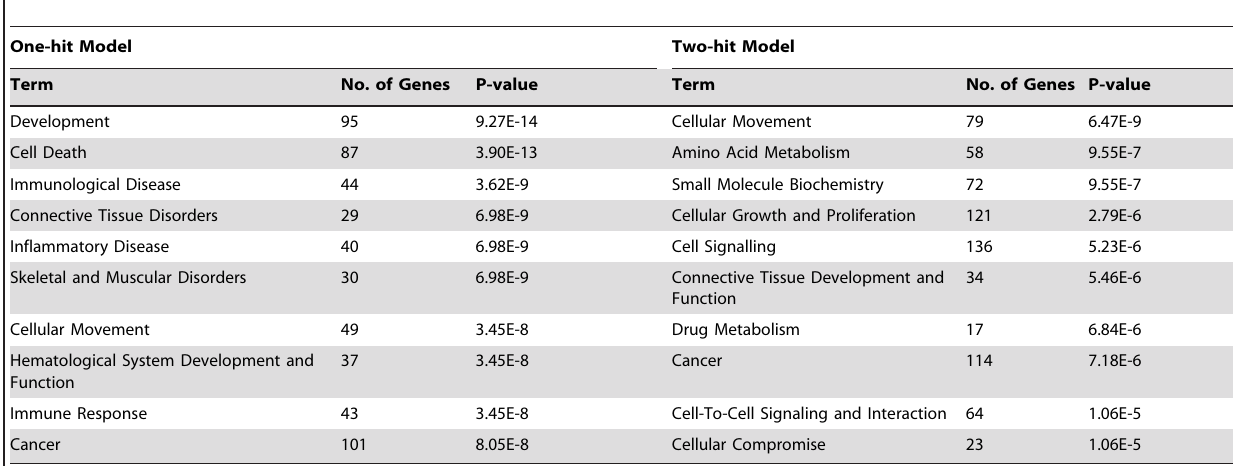
Table 5. Predicted functional enrichment for genes identified by the one-hit and two-hit models of VILI.